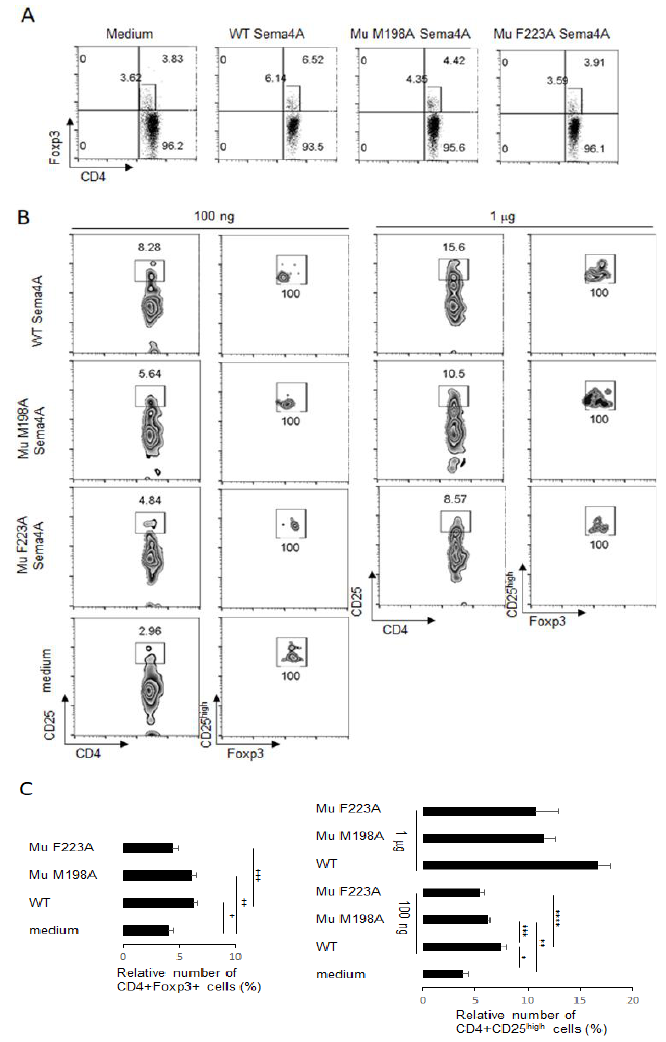
Figure 8. Mutant Sema4A molecules are less potent in the stabilization of human peripheral Treg cells in vitro as compared to WT recombinant Sema4A protein. Human PBMC were cultured with or without 100 ng of external WT Sema4A or Mu Sema4A for 48 h. After harvest, the numbers of Treg cells (panels ( A , C) ) were assessed by flow cytometry, using specific Abs to corresponding cell